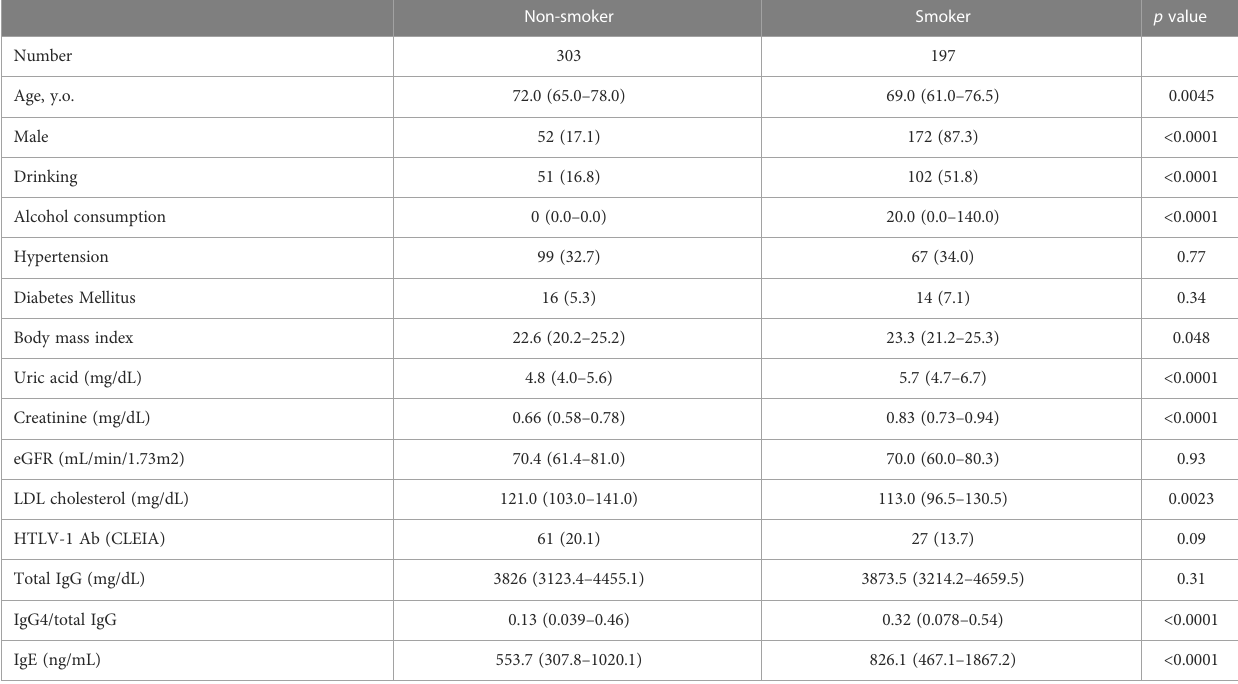
TABLE 3 Univariate analysis strati fi ed by smoking in NaIS.